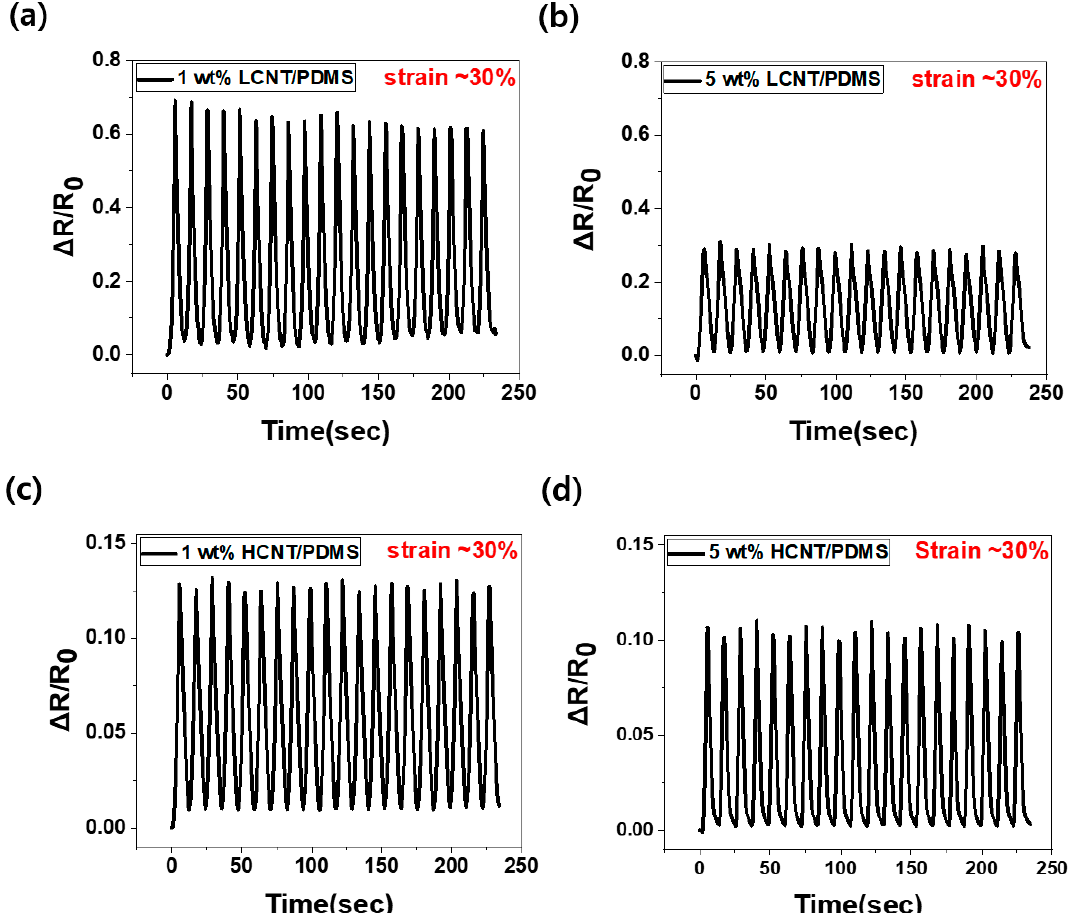
Figure 7. Normalized change in resistance ( Δ R/R 0 ) under 20 cycles of continuous tensile deformations to 30% strain: ( a ) Case of 1 wt% LCNT / PDMS, ( b ) case of 5 wt% LCNT / PDMS, ( c ) case of 1 wt% HCNT / PDMS, and ( d ) case of 5 wt% HCNT / PDMS. (For all samples, 30 pre-discontinuous cycles were executed before the continuous cyclic test).